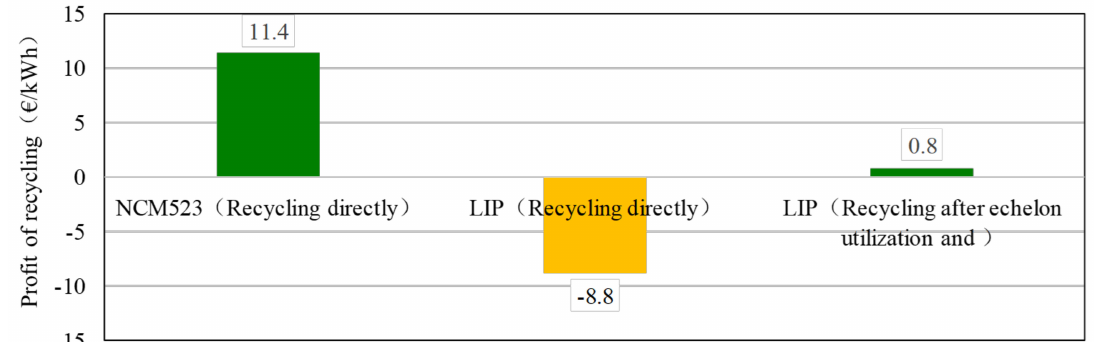
Figure 9. Analysis of the economic benefits of recycling of the retired power